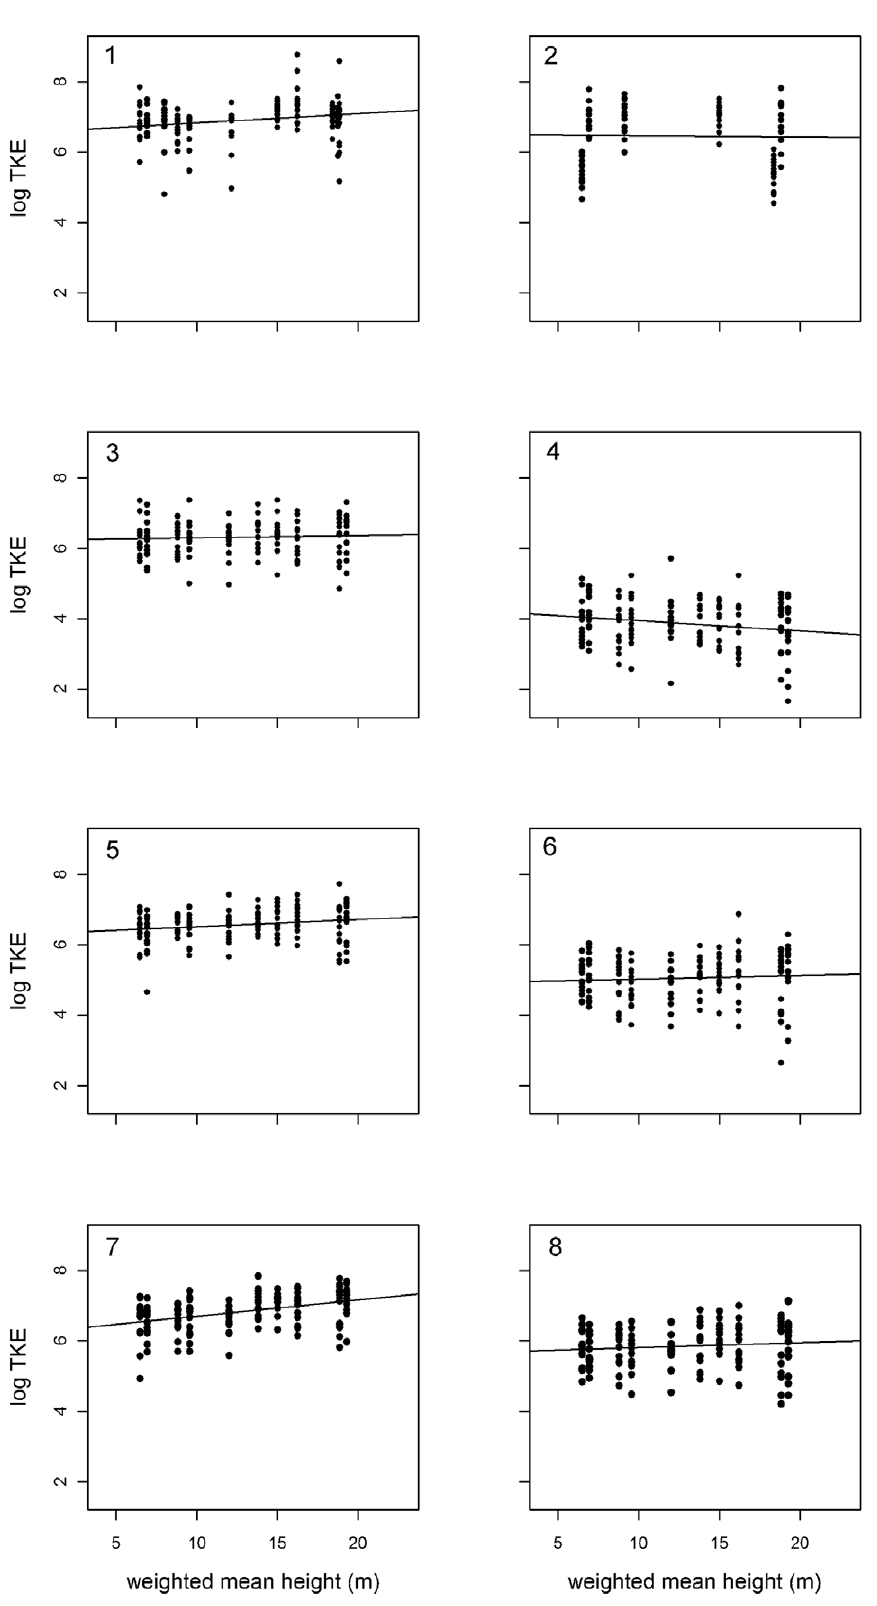
Figure 2. Relation between log TKE and weighted mean height of the tree layers for rainfall events 1 to 8. Black dots represent the study plots. See Table 1 for the properties of the precipitation events.